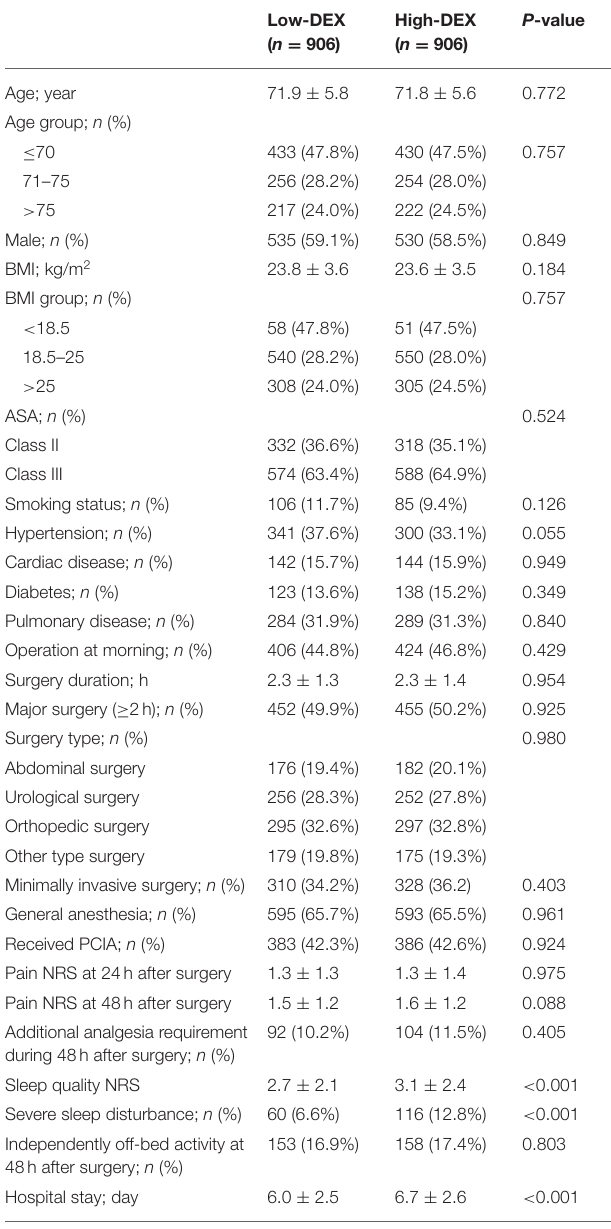
TABLE 3 | Comparisons of the clinical characteristics and postoperative outcomes between Low-DEX and High-DEX patient groups after PSM analysis. Low-DEX ( n =